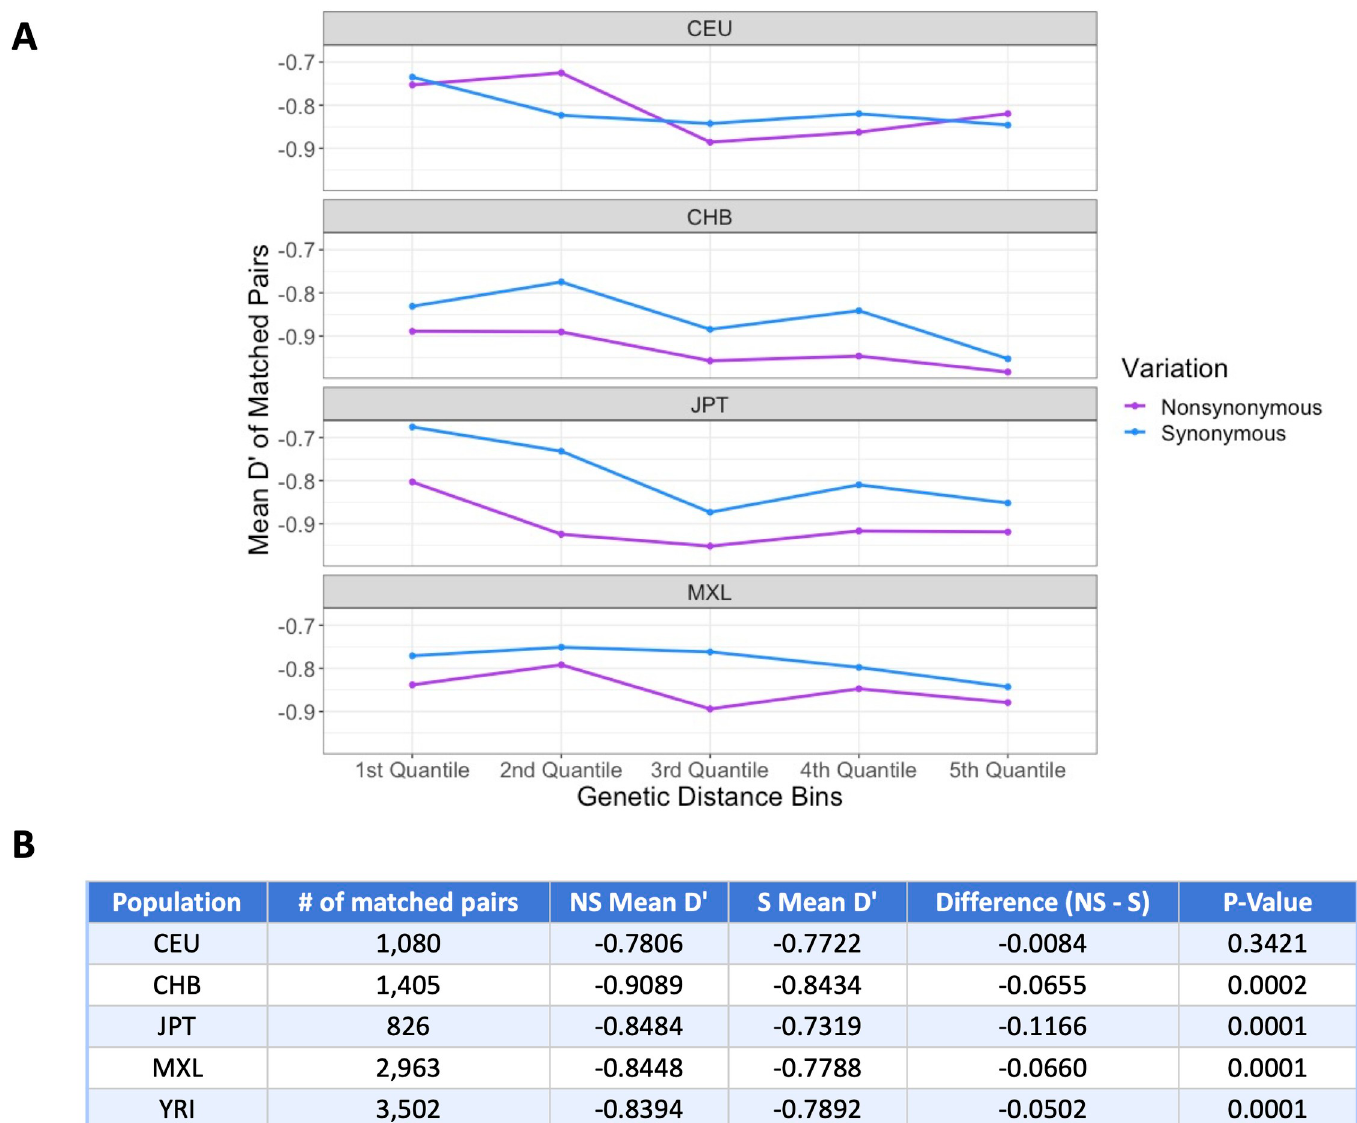
Fig 4. Results from the matched-pairs permutation test for non-African 1KGP populations. (A) Across four other populations in the 1KGP, NS pairs of variants have lower values of D ’ (i.e. have more negative LD) than their matched S counterparts. The quantile bins on the x-axis were set by combining all pairs of variants across all populations and assigning them into 5 bins based on the centimorgan distance between variants with roughly equal numbers of pairs in each bin. Thus, each population has the same centimorgan distance used to define each bin. (B) Matched-pairs permutation test shows significantly more negative average LD between pairs of NS SNPs than S SNPs in all populations except the CEU population, where this difference is not